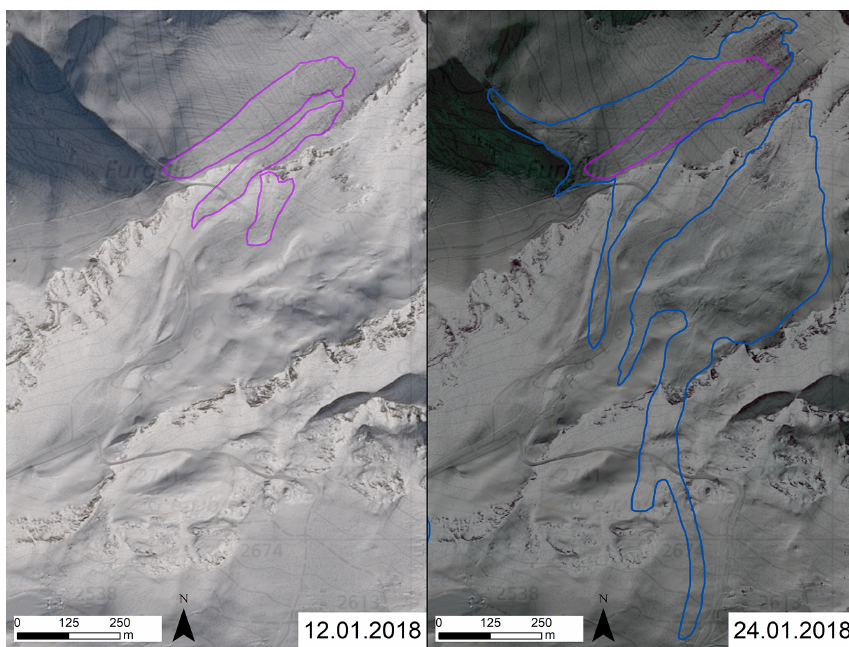
Figure 6. SPOT6 images from 12 and 24 January from close to Oberrothorn, VS (SPOT6 data © Airbus DS 2018). The purple avalanche outlines are those visible in the imagery acquired first (left). One of these avalanche outlines is still visible after the second avalanche period 12d later (right). The blue outlines were released during the second avalanche period. Pixmap © 2019 swisstopo (5704000000), reproduced with permission of swisstopo (JA100118).